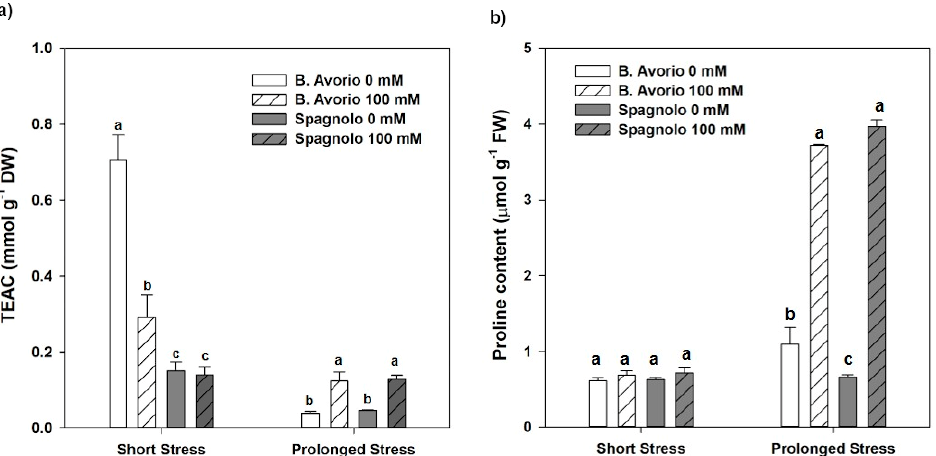
Figure 3. E ff ects of salt stress on relative expression of phenylpropanoids and sesquiterpenes key biosynthetic genes measured upon prolonged (21 days) stress treatment (100 mM NaCl) in leaves of “Bianco Avorio” and “Spagnolo” genotypes of C. cardunculus var altilis . ( a ) qRT- PCR analysis of HCT, HQT, FNSII , F3 (cid:48) H and MYB12 TF; ( b ) qRT-PCR analysis of GAS, GAO and COS . Results are expressed as fold changes relatively to the relevant unstressed control (21 days, 0 mM NaCl) of each genotype. Each value represents the mean ± SD of three biological and 2 technical replicates. Values indicated with di ff erent letters are significantly di ff erent between genotypes and treatments at p < 0.05, by analysis of variance (ANOVA).